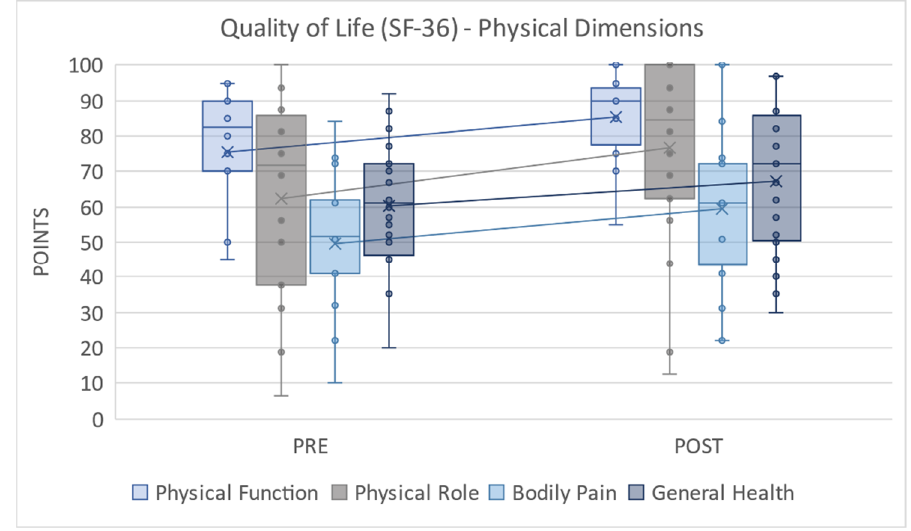
Figure 3. Quality of Life (SF-36)—Physical Dimensions; PRE = pretest; POST = posttest.